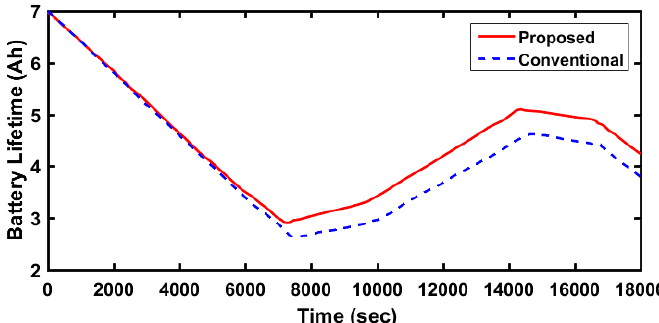
Figure 24. Battery lifetime comparison of the proposed and conventional models. Table 3. SOC estimation accuracy comparison.